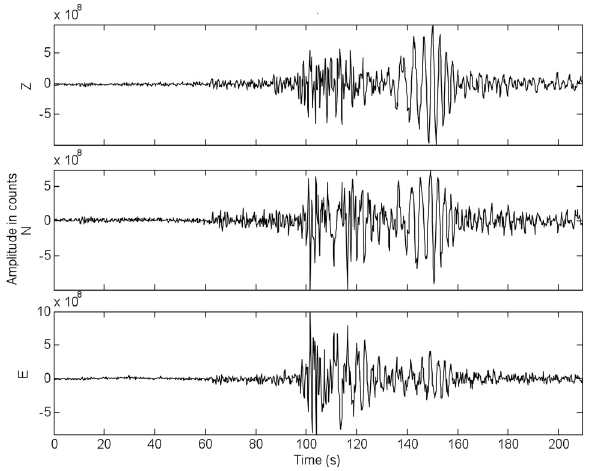
Figure 3. Broadband waveform of BHPL from the April 17, 2006, Koyna earthquake ( Δ = 7.01°, mb = 4.4, Table 1, event no. 4). Wave- form starts at 16:44:55.78. Although the amplitudes of body waves are weak but Rayleigh and Love waves are